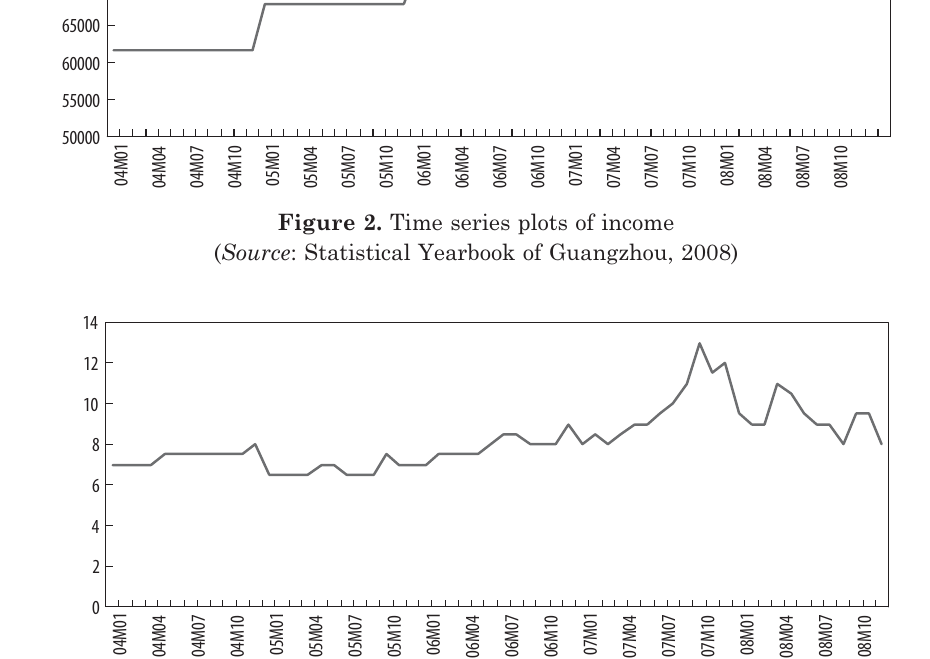
Figure 3. Time series plots of housing price to income